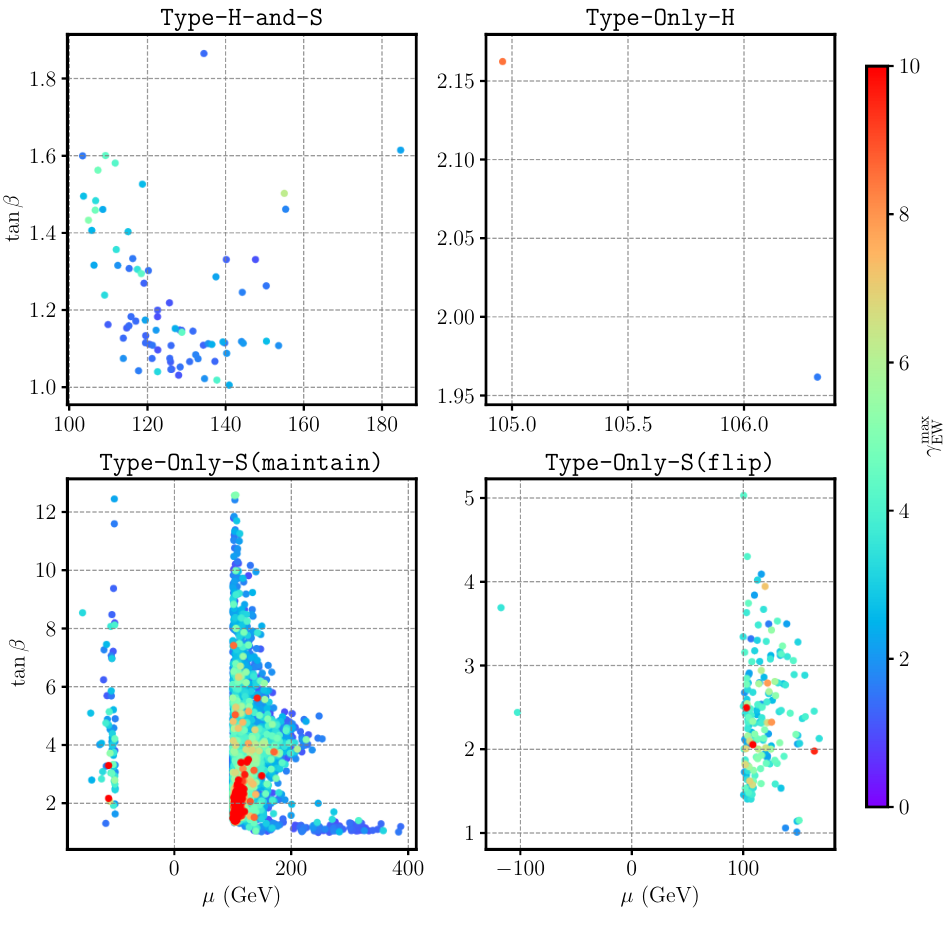
Figure 10 . ( (cid:22) e(cid:11) ; tan (cid:12) ) for samples for which the strongest FOPT does not end in the SM vacuum. The points are colored by the (cid:13) EW of the strongest